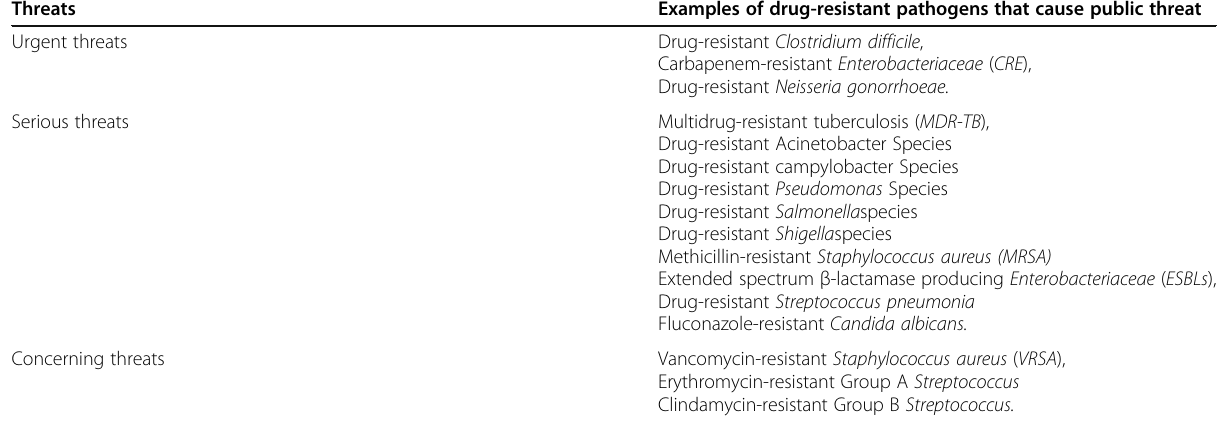
Table 1 Centre for Disease prevention and Control (CDC) classification on drug-resistant infections Threats